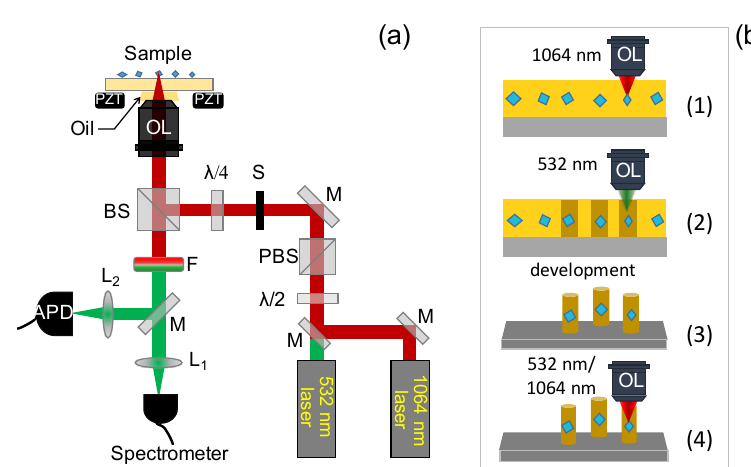
Figure 1. ( a ) Experimental setup of the integrated optical system for fabrication of desired polymeric structures and for characterization of SHG of a single KTP NP. PZT: piezoelectric translator, OL: oil immersion microscope objective, λ /4: quarter-wave plate, λ /2: half-wave plate, BS: unpolarizing